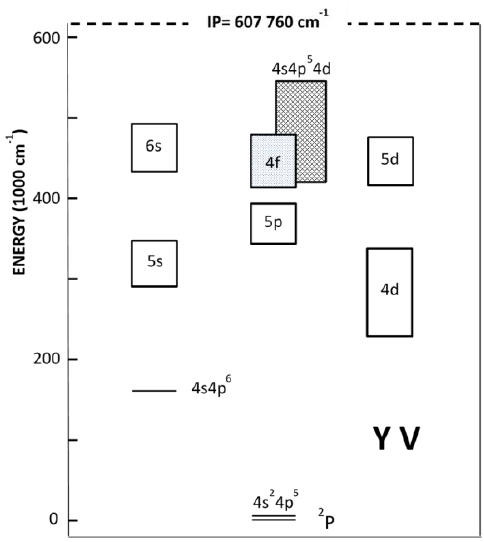
Figure 1. Schematic overview of the observed configurations of Y V. The calculated positions of the 4s 2 4p 4 4f and 4s4p 6 4d configurations are also shown.